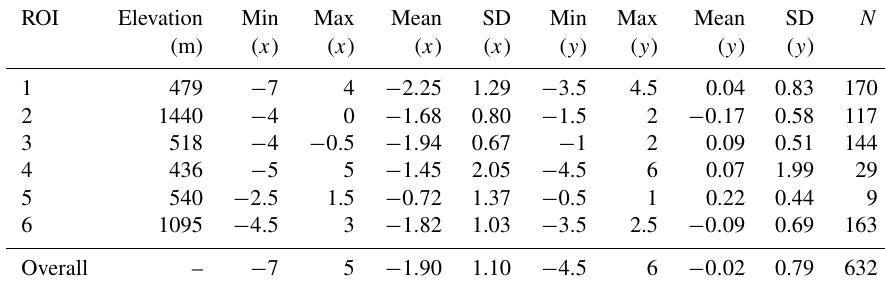
Table 3. Summary of the results for the scene of MetOp-A. The unit of the shift is kilometers. ROI Elevation